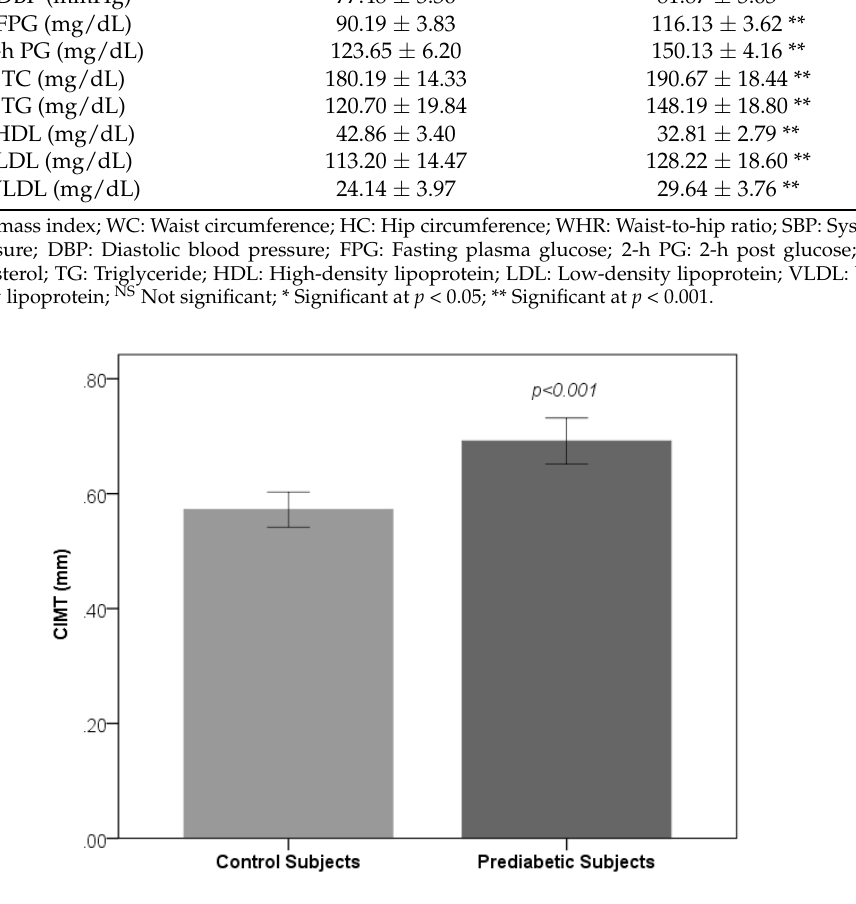
Table 1. Sociodemographic and biochemical characteristics of the studied subjects.